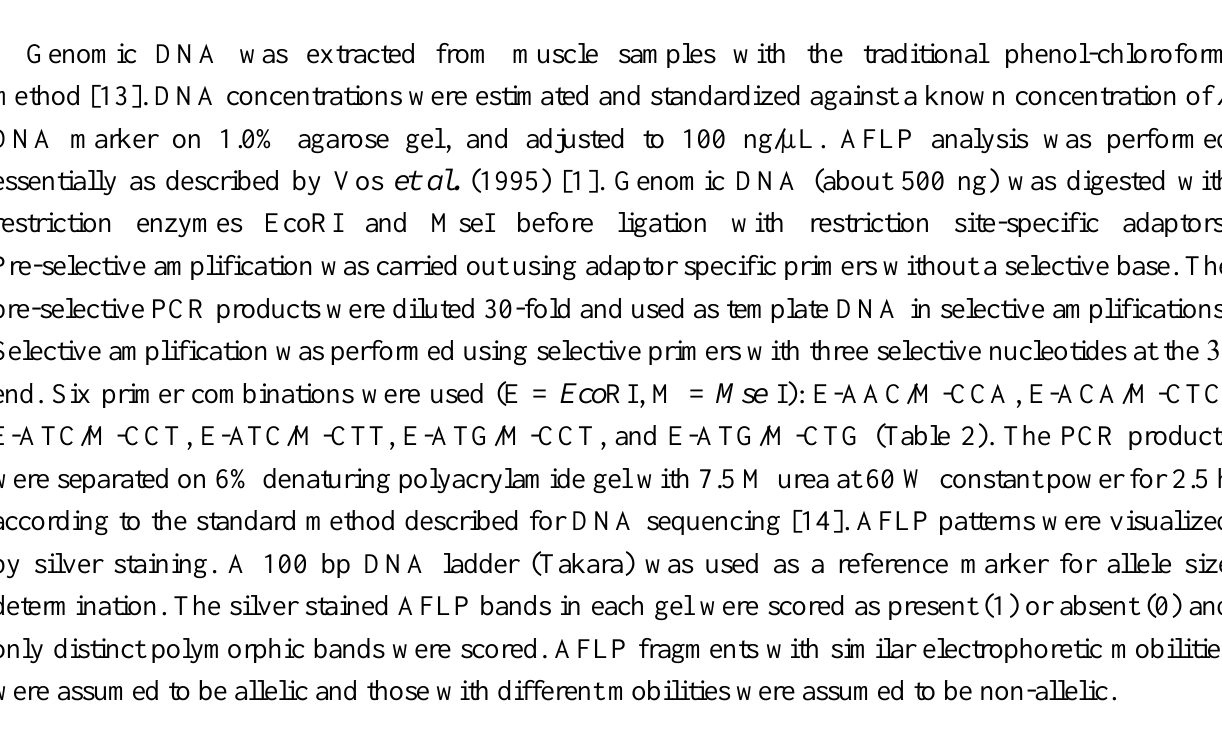
Table 2. Adaptors and six primer combination sequences used in the